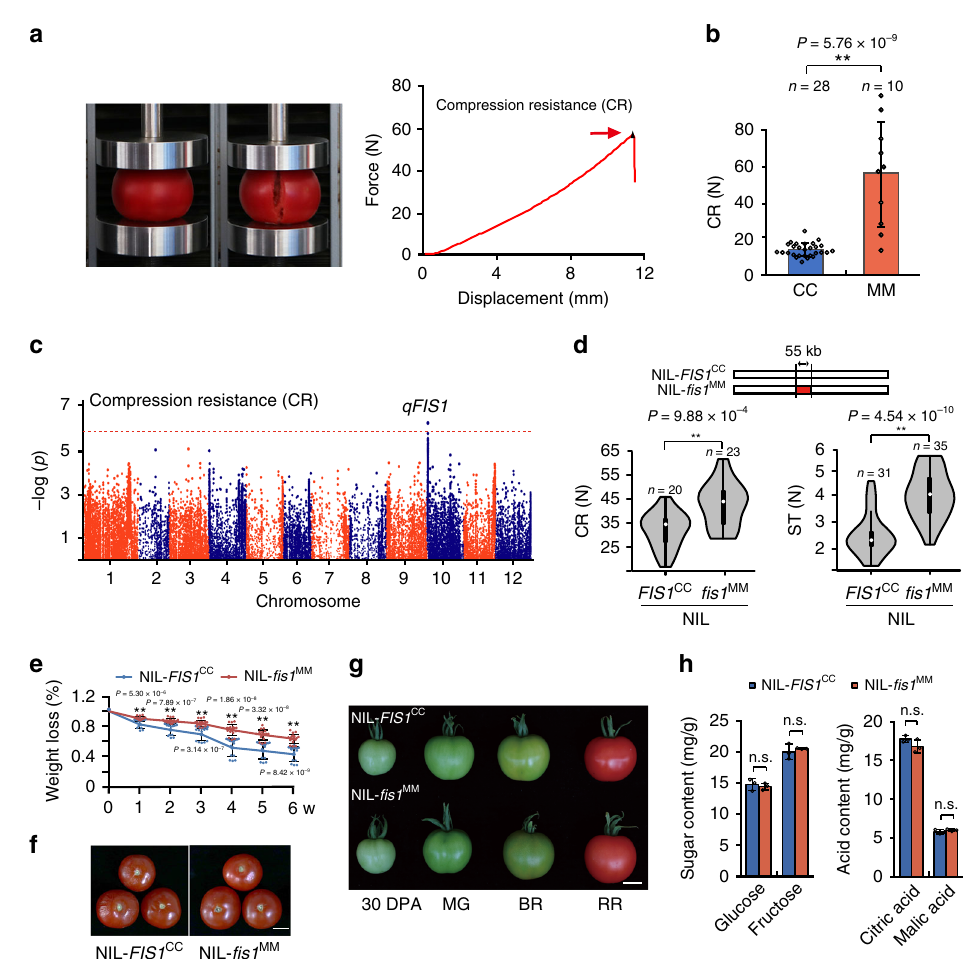
Fig. 1 Identi fi cation and characterization of qFIS1 . a Photos show the setup for measuring the compression resistance (CR) of tomato red ripe fruits by a texture analyzer. The red arrow indicates the pressure when the fruit is broken. b CR of two parental lines. Error bars, mean ± SD. n = fruit number. The asterisks indicate a statistically signi fi cant difference (two-tailed Student ’ s t -test, ** P < 0.01). c Manhattan plots of SNPs associated with CR in the RIL population. The horizontal red line indicates the genome-wide signi fi cance threshold (1 × 10 − 6 ), and the x axis shows the chromosomal position. d Diagram of the DNA region that differed in the two NILs and violin plots of compression resistance (CR) and skin toughness (ST) for NIL- fi s1 MM and NIL- FIS1 CC red ripe fruits. n = fruit number. The asterisks indicate a statistically signi fi cant difference (two-tailed Student ’ s t -test, ** P < 0.01). e Water loss of NIL- fi s1 MM and NIL- FIS1 CC red ripe fruits during storage. w, week; Error bars, mean ± SD. Seventeen fruits for NIL- FIS1 CC and 18 fruits for NIL- fi s1 MM were used for this experiment. The asterisks indicate a statistically signi fi cant difference (two-tailed Student ’ s t -test, ** P < 0.01). f Pictures of NIL- fi s1 MM and NIL - FIS1 CC red ripe fruits stored at room temperature for 2 weeks. Bar = 2 cm. g NIL- fi s1 MM and NIL- FIS1 CC fruits at different developmental stages. 30 DPA, 30 days post anthesis; MG, mature green; BR, breaker; RR, red ripe. Bars = 2 cm. h Contents of sugars and acids of NIL- fi s1 MM and NIL- FIS1 CC red ripe fruits. Error bars, mean ± SD. n = three biological replicates. n.s., no signi fi cant difference (two-tailed Student ’ s t -test, P >